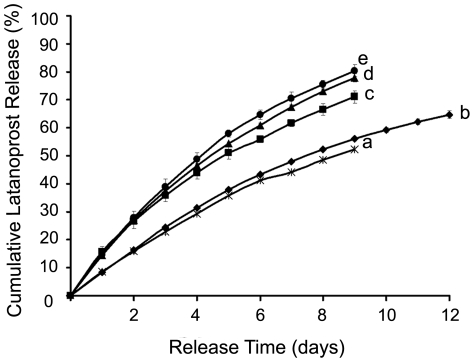
In vitro dialysis study of latanoprost from drug loaded DPPC LUVs after extrusion.Cumulative latanoprost release (%) from DPPC LUVs loaded with varying amount of drug/lipid mole ratios: (a) 0.044, (b) 0.11, (c) 0.14, (d) 0.18 and (e) 0.37. Each value is the mean (standard deviations is plotted as error bars, which are always less than 3% for nearly all batches) of the results obtained from at least three independent experiments.